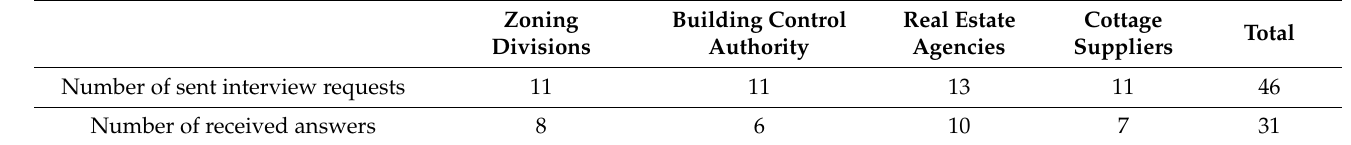
Table 1. Interviewee categories, interview requests, and received answers.